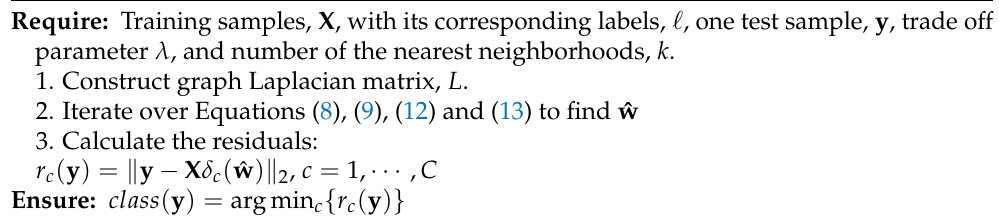
Algorithm 2 Proposed sparse representation classification